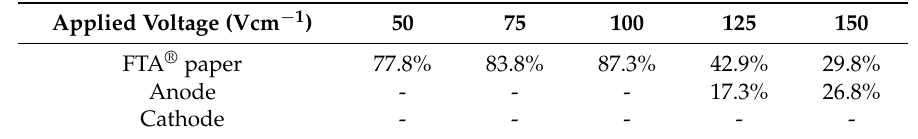
Table 1. Results showing the amounts of qPCR products formed as a percentage of the original template DNA added, which are amplified from different locations (FTA ® paper disc, anode and cathode reservoirs) when FTA ® discs were subjected to a range of voltages for DNA purification on microfluidic